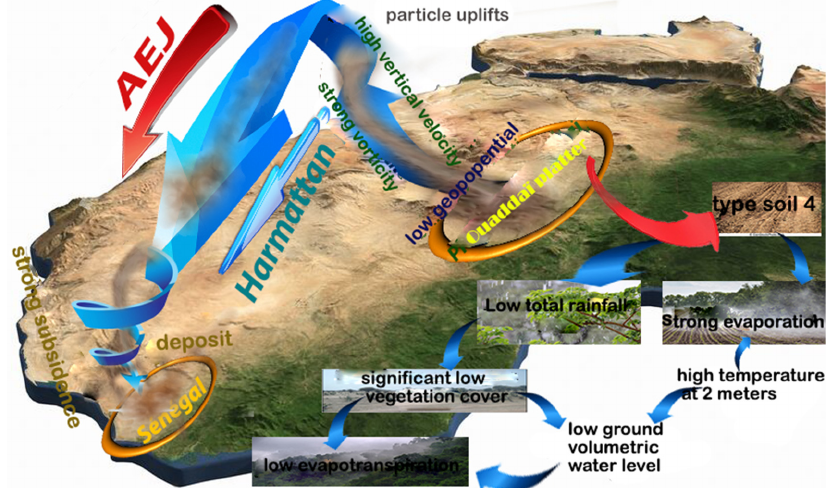
Figure 19. Schematic map summarizing the uplift process from the Ouaddaï plateau in Chad to Senegal. to